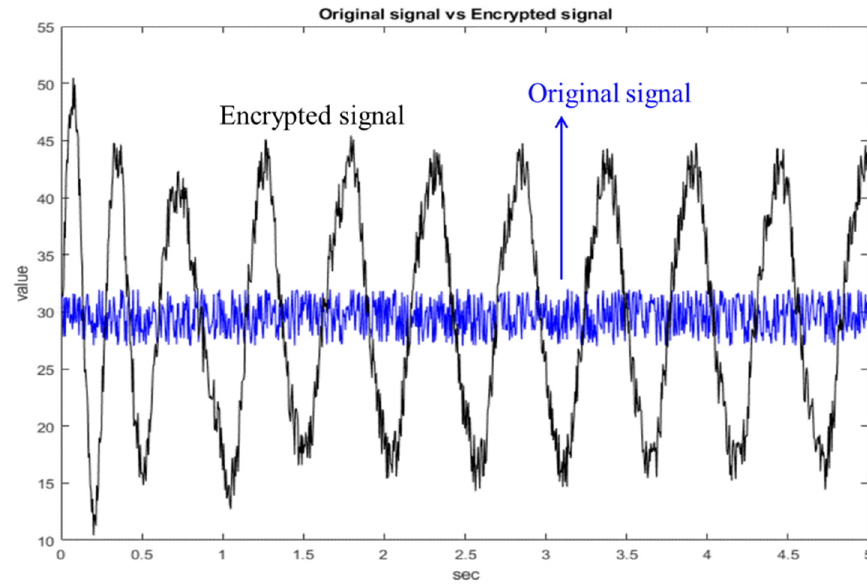
Figure 10. Comparison chart of original signal and encrypted signal.